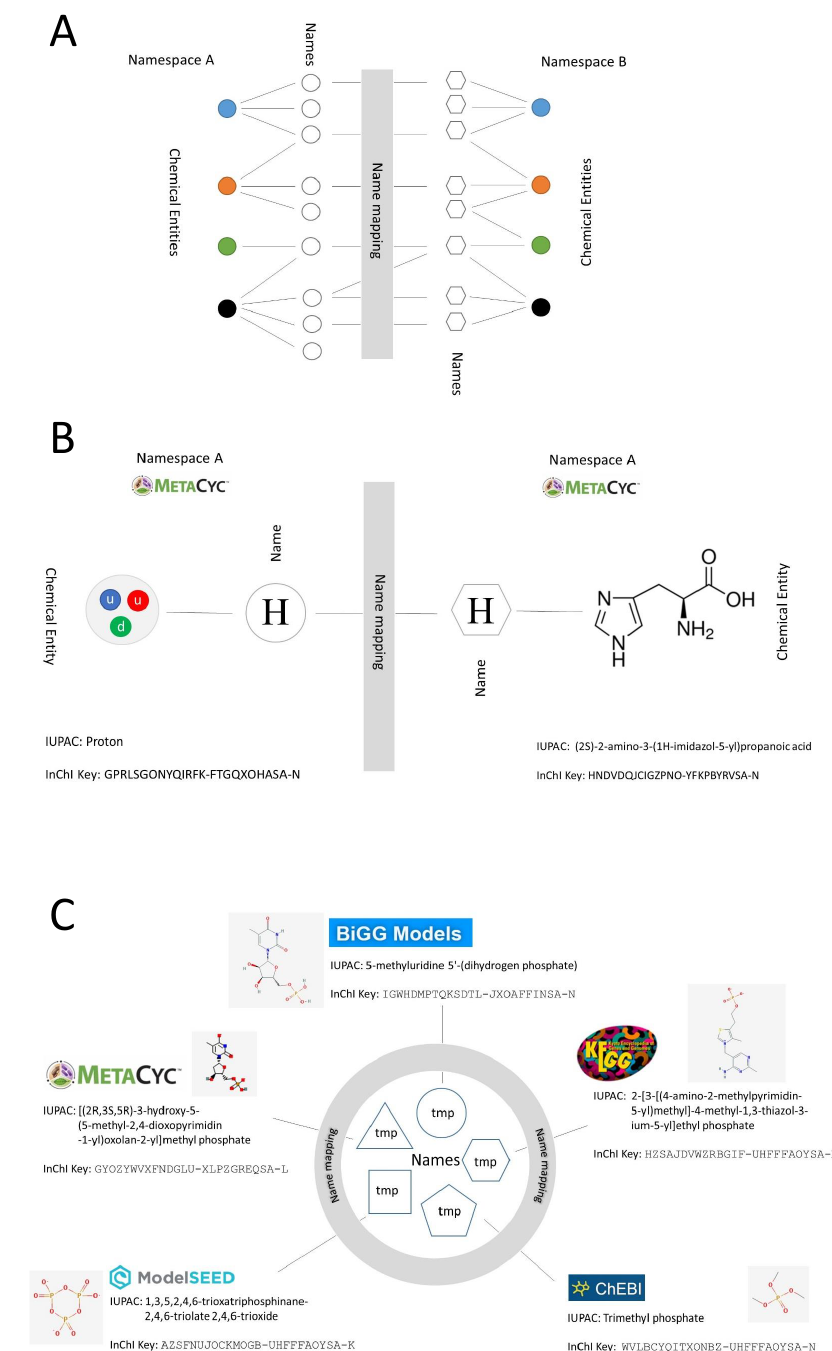
Figure 1. Overview of namespace mapping problems. ( A ) The same chemical entities (coloured nodes) link to different names (colourless nodes) in different namespaces: names in namespace A may link to different chemical entities in namespace B; ( B ) Example of inconsistency within the same namespace: the same name links to different chemical compounds; ( C ) Example of inconsistency between different namespaces: the same name links to different compounds in different databases. Chemical entities are represented with coloured nodes, names are represented with colourless